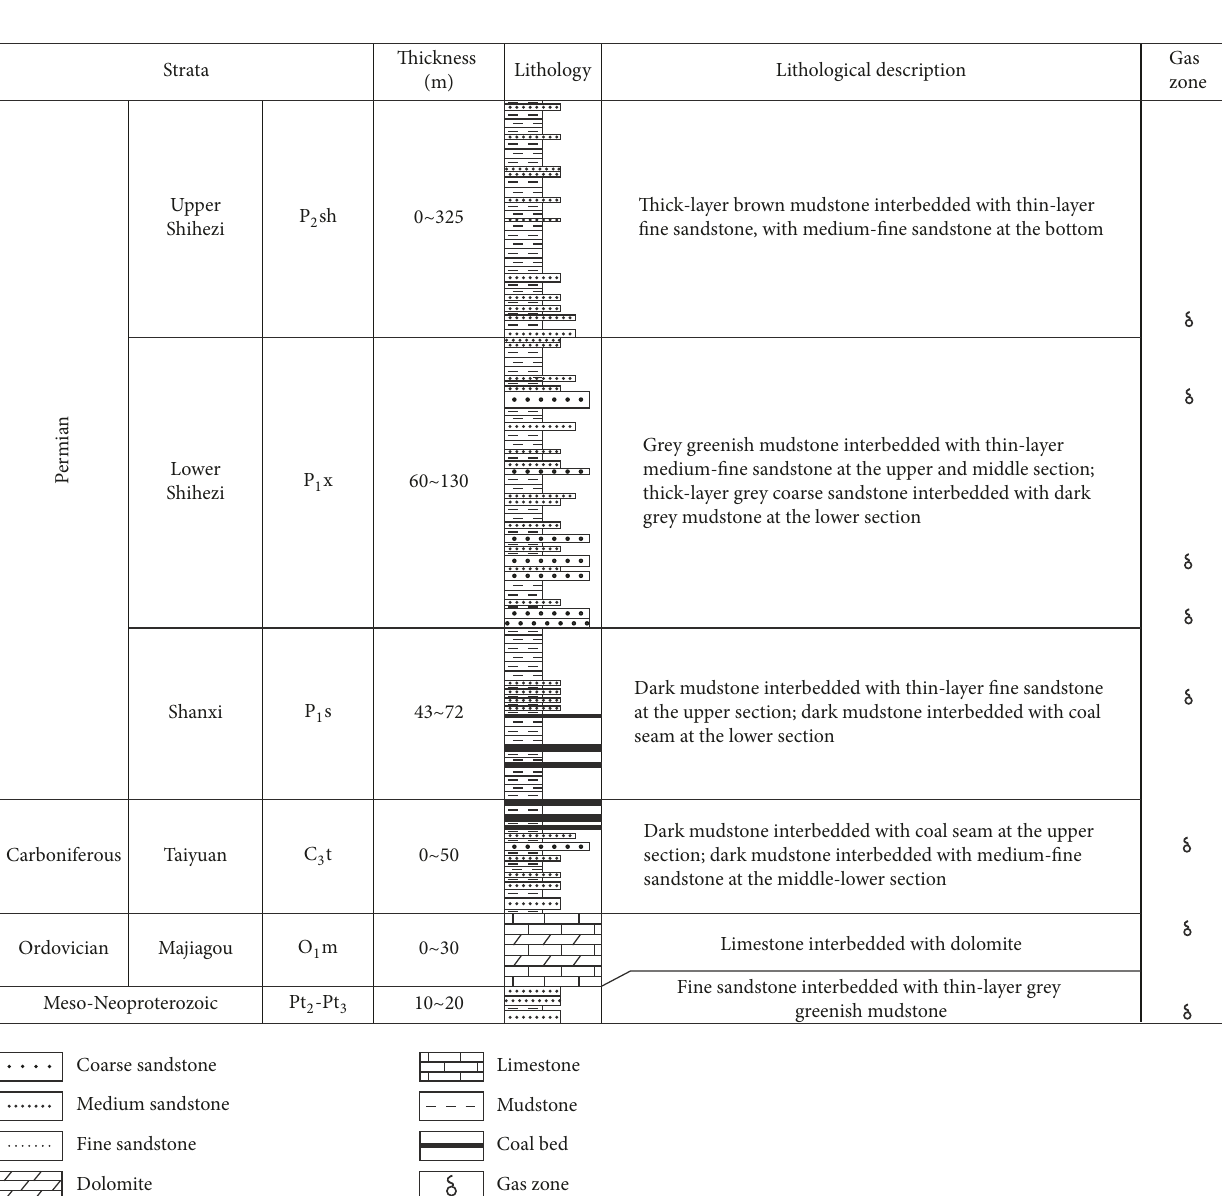
Figure 2: Stratigraphic column of the Hangjinqi area in the Ordos